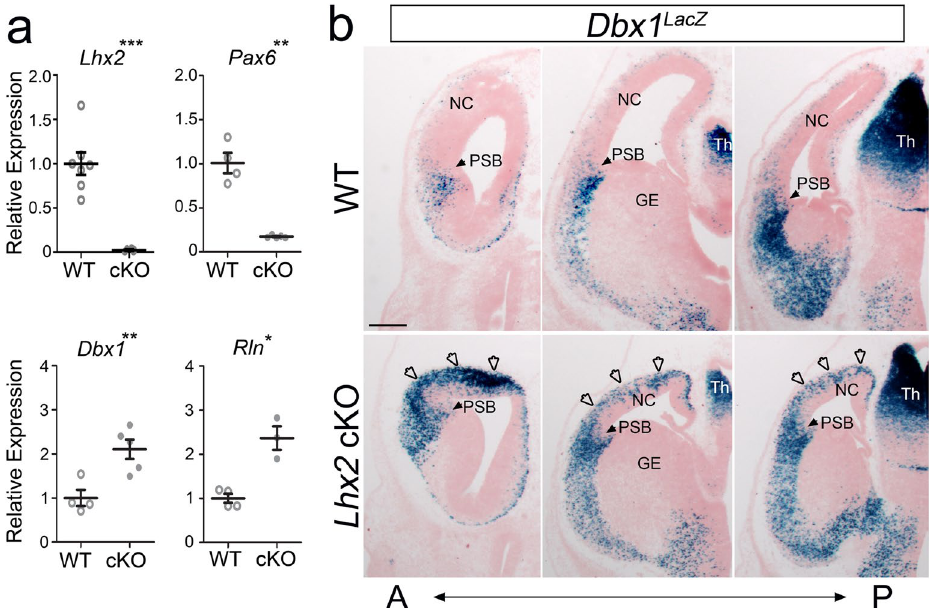
Figure 1. Dbx1 is upregulated in Lhx2 conditional knockout cortices. ( a ) According to qPCR, the expression levels of Lhx2 and Pax6 are significantly downregulated in the cKO ( Lhx2 f/f ; Emx1 Cre ) cortex when compared with WT ( Lhx2 fl/ + ) at E13.5, while the levels of Dbx1 and Rln are significantly upregulated in cKO mice (n = 3–5; Lhx2 , P < 0.001; Pax6 , P = 0.0054; Dbx1 , P = 0.0085; Rln , P = 0.0412). ( b ) LacZ staining on coronal sections of Dbx1 LacZ cortices of WT (top) and cKO (bottom) embryos at E13.5. From anterior (A) to posterior (P), LacZ + cells (blue) are specifically located in the pallial–subpallial boundary (PSB, arrowheads) in WT. An increased number of LacZ + cells (indicated by unfilled arrowheads) was observed in the neocortex (NC) of the cKO. Scale bar, 200 µm. GE, ganglionic eminence; Th,